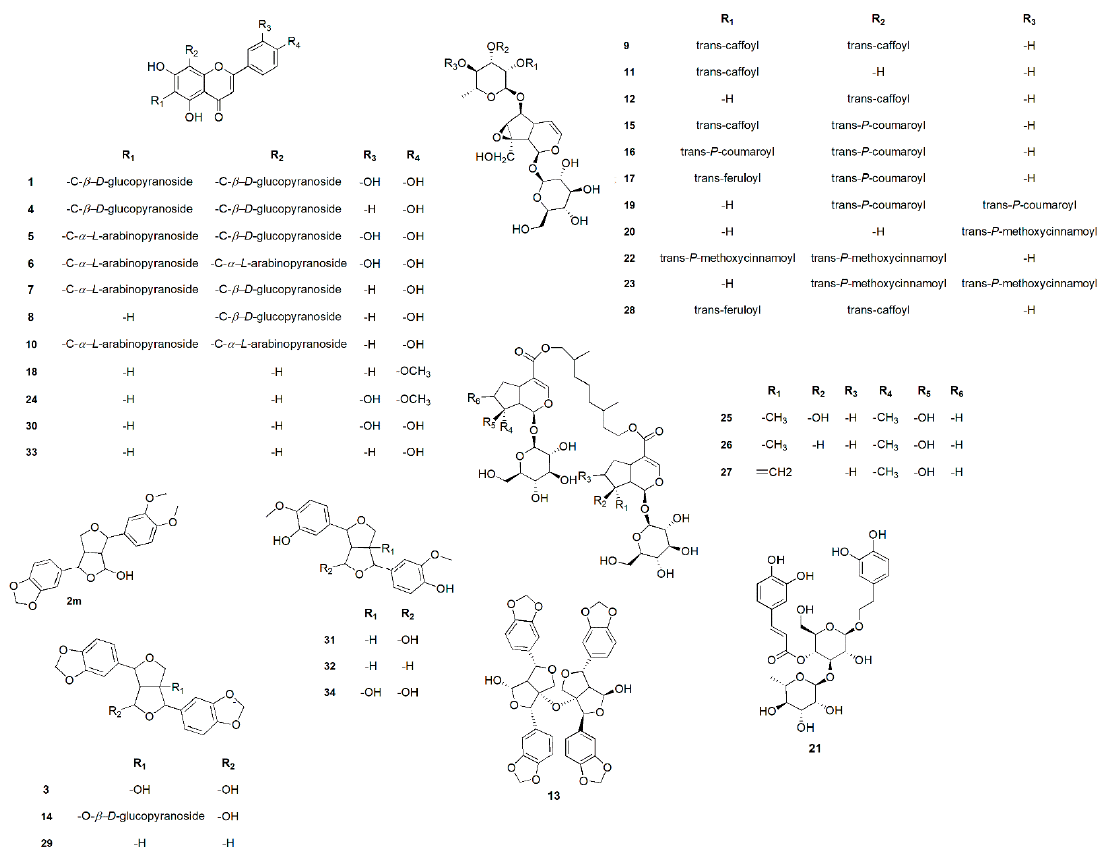
Figure 1. Dereplicated metabolites from the LC–HRESIMS analysis of Premna odorata bark, wood, young stems, flowers, and fruit.